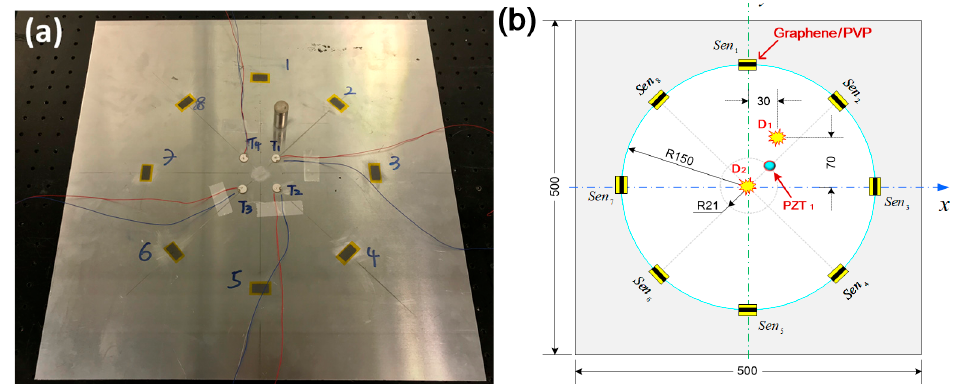
Figure 6. ( a ) 6061T aluminum with the spray-on graphene/PVP sensors and a PZT wafer; ( b ) locations of the actuator, sensors, and damage (unit: mm).